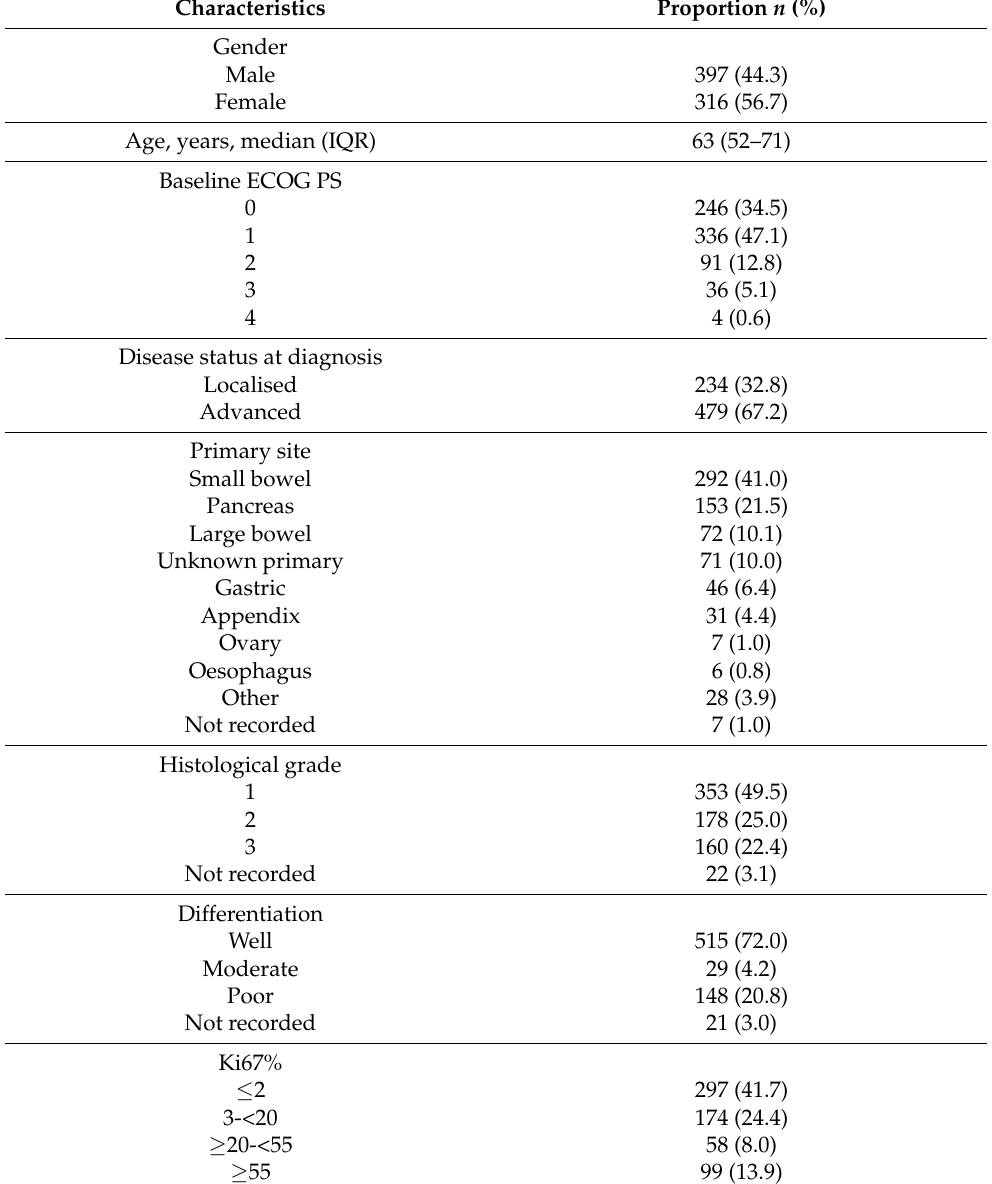
Table 1. Baseline characteristics of patients with extra-pulmonary neuroendocrine neoplasms without brain metastases ( n =